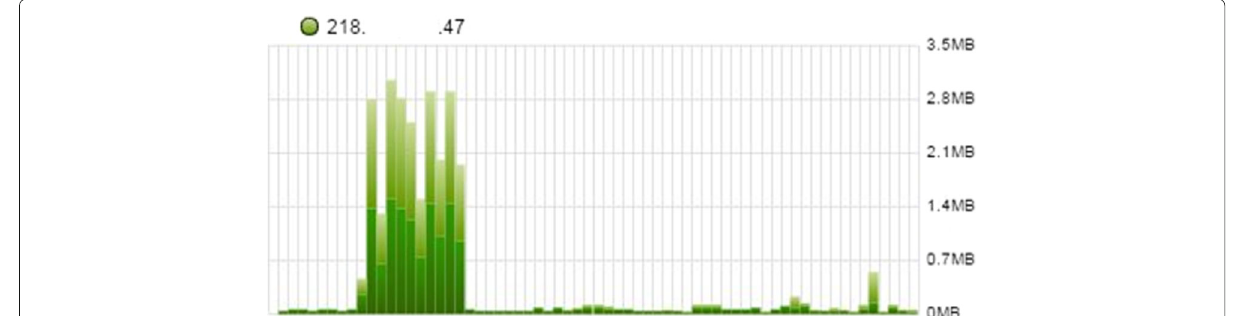
Fig. 14 Data communication graph using